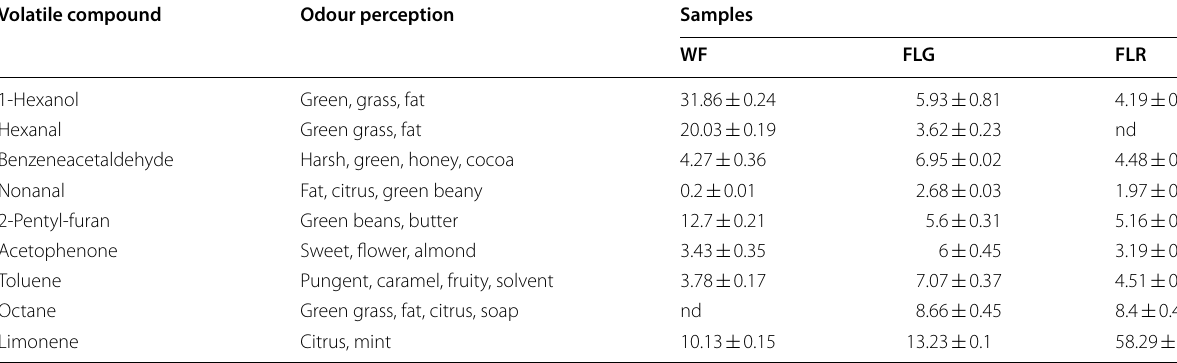
All data are the means and standard deviation of triplicate measurements. Abbreviations are as in Table 1